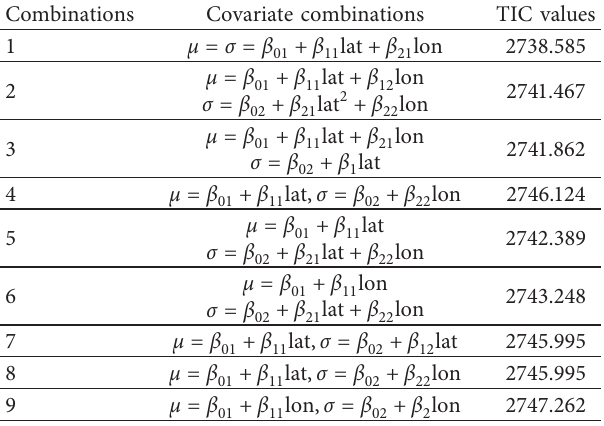
Figure 5: The relationship between the scale parameter of the spatial GEV model and the covariates latitude and longitude. Table 2: Model selection criteria for spatial GEV model with Table 3: Spatial GEV response surface coefficients estimation various combinations of covariates using Takeuche information criteria (TIC).